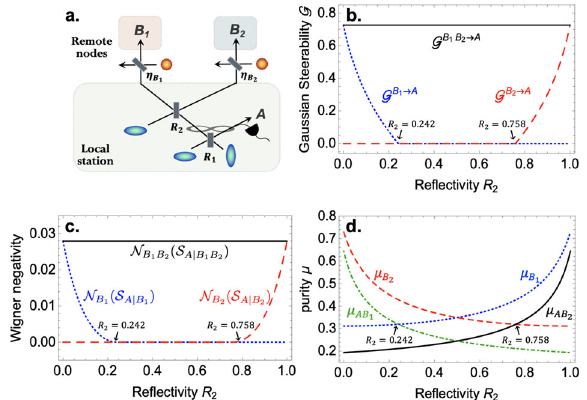
Fig. 4 Remotely generated Wigner negativity and initial Gaussian steering and purity in a lossy tripartite scenario. a A similar scheme as that shown in Fig. 2 but now both two output modes are distributed over lossy channels. b Fixing R 1 : (1 − R 1 ) = 50: 50, η B ¼ 1 η : 8 and input squeezing levels r = 1, the initial Gaussian B 2 ¼ 0 steerabilities change with a variable R 2 . c After a single-photon subtraction on mode A , the remotely generated Wigner negativities of mode B 1 , mode B 2 and the group ( B 1 B 2 ), respectively. d Some local purities of the initial Gaussian state. The remaining cases are constants with the current setting, i.e., μ A = 0.266, μ B ¼ 0 : 227 and 1 B 2 μ : 469 AB 1 B 2 ¼ 0